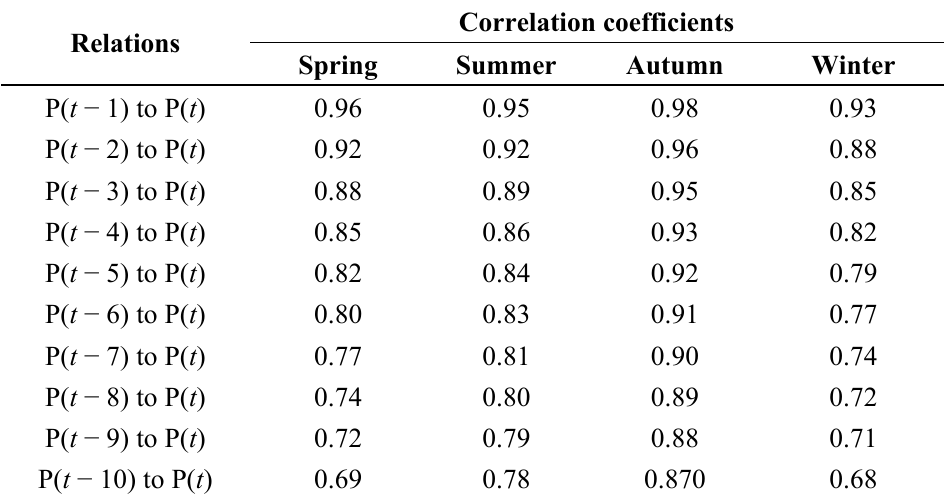
Table 1. Correlation coefficients between two wind power time series ( t is the index for hours). Relations